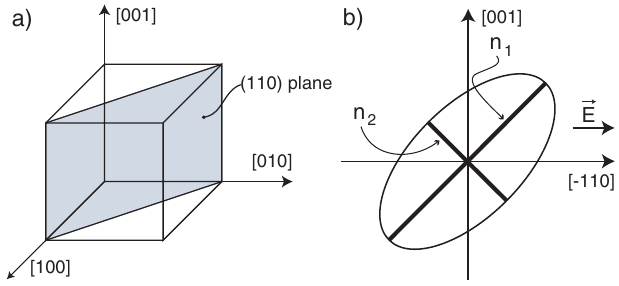
FIG. 2. (Color) (a) The (110) plane in the cubic GaP crystal. (b) The refractive index ellipsoid projected onto the (110) plane of the EO crystal. The difference between the refractive indices n and n is strongly exaggerated. Both the THz pulse and the 1 2 laser pulse impinge along the normal to the (110) plane and are linearly polarized parallel to the ½(cid:1) 1 ; 1 ; 0 (cid:2) axis. The angle between the principal axis of the ellipse and the ½(cid:1) 1 ; 1 ; 0 (cid:2) axis is 45 (cid:3)